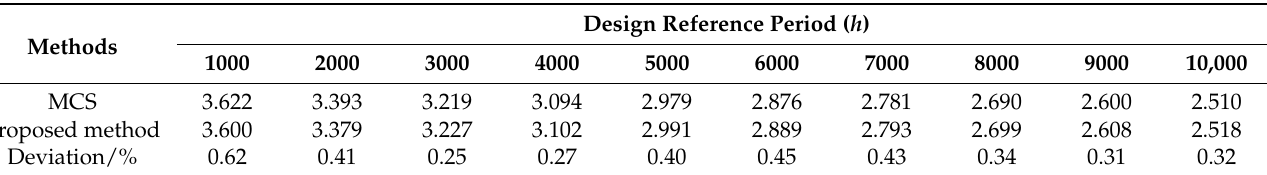
Table 2. Reliability index of the mechanical part in each design reference period.